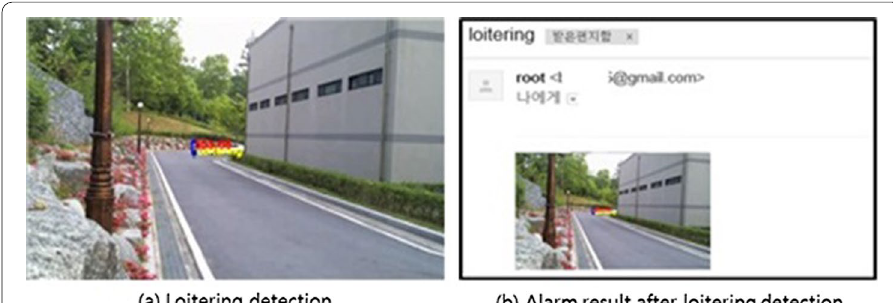
Fig. 19 Notify in case of an abnormal situation (loitering)